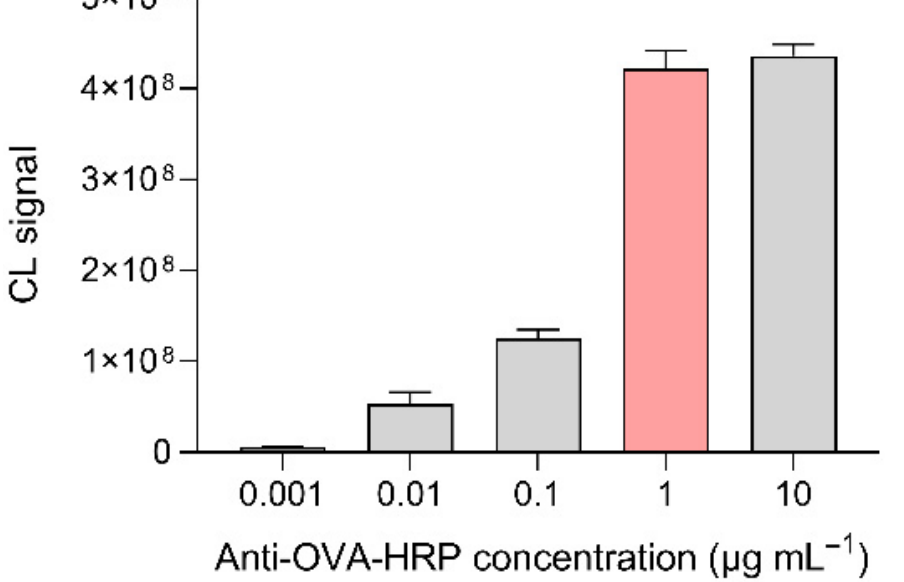
Figure 5. CL signals obtained by analyzing OVA-free solutions (PBS) in origami µ PADs prepared using anti-OVA-HRP solutions at different concentrations. The optimal anti-OVA-HRP concentration is highlighted in red. Each of the data are the mean ± SD of three measurements.